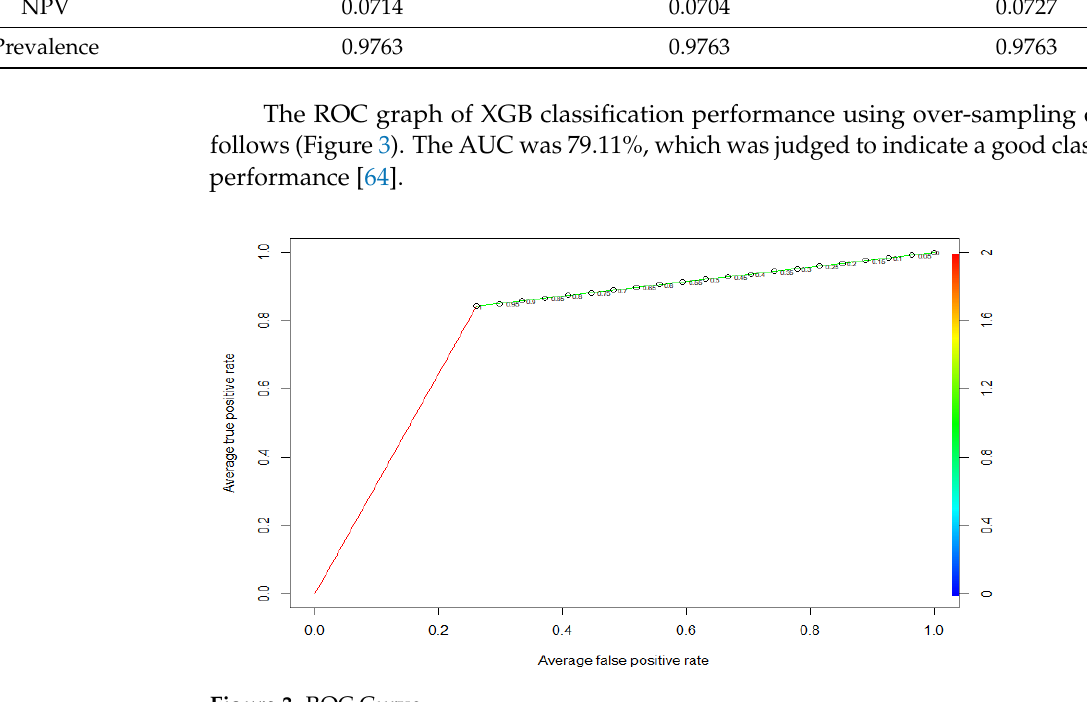
Figure 3. ROC Curve.